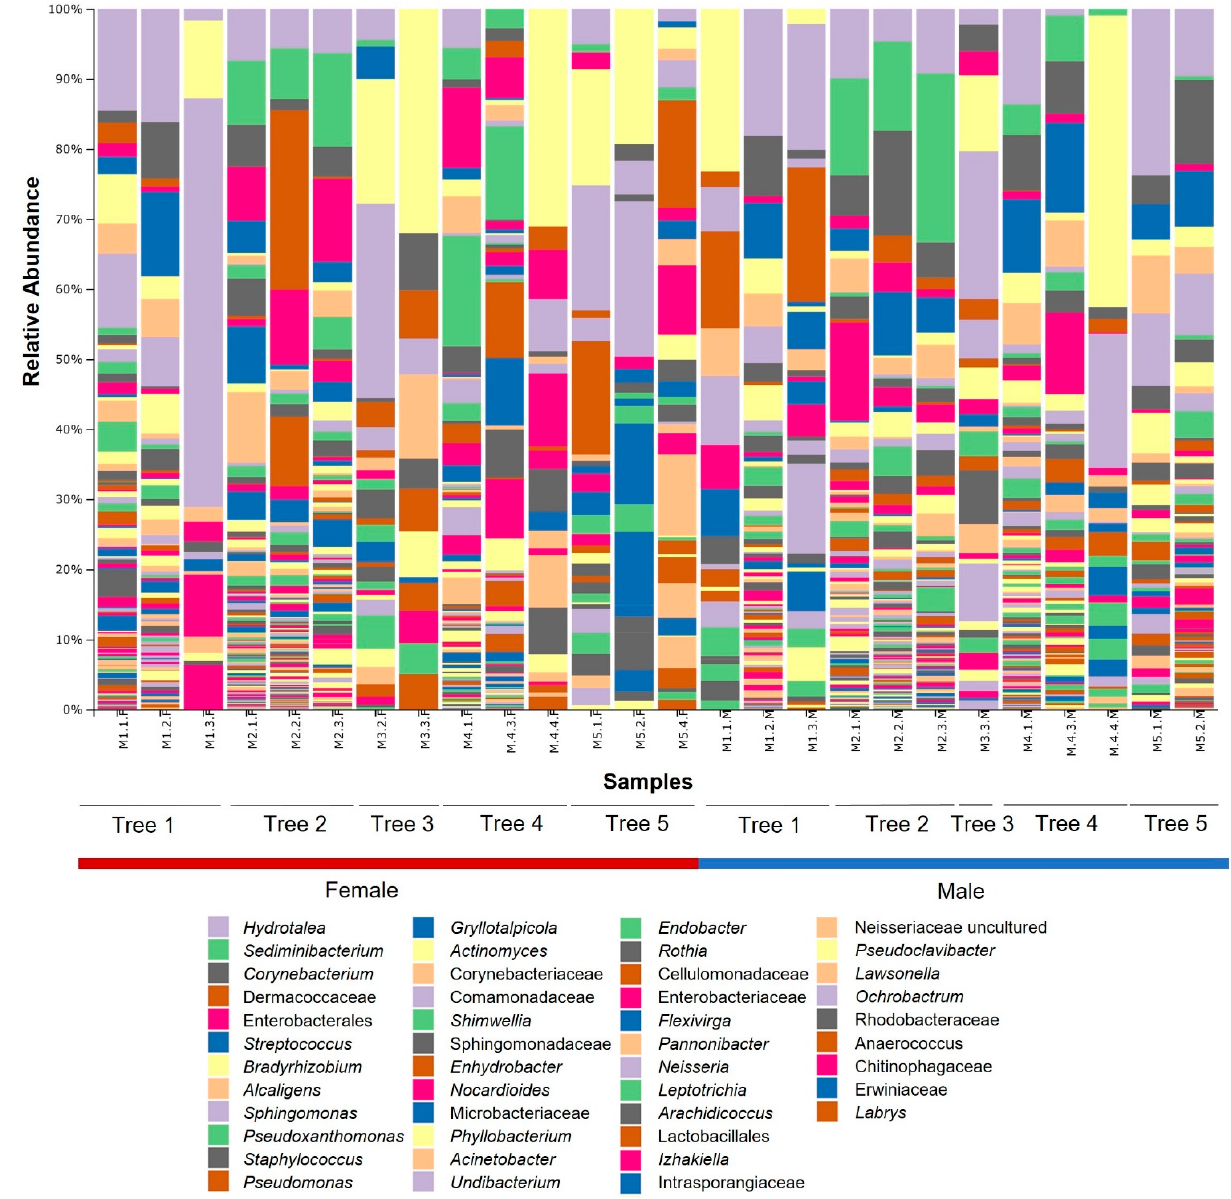
Figure 2. Bacterial community composition in female and male P. cylindrus mycangia. Bar charts show the relative abundance of bacteria at the genus level (order or family level if not further classifiable) across the 14 female and 12 male samples. Each bar corresponds to a pool of three individuals of the same sex collected from the same gallery. Only the 45 major genera (relative abundance > 0.5%) are displayed in the legend.